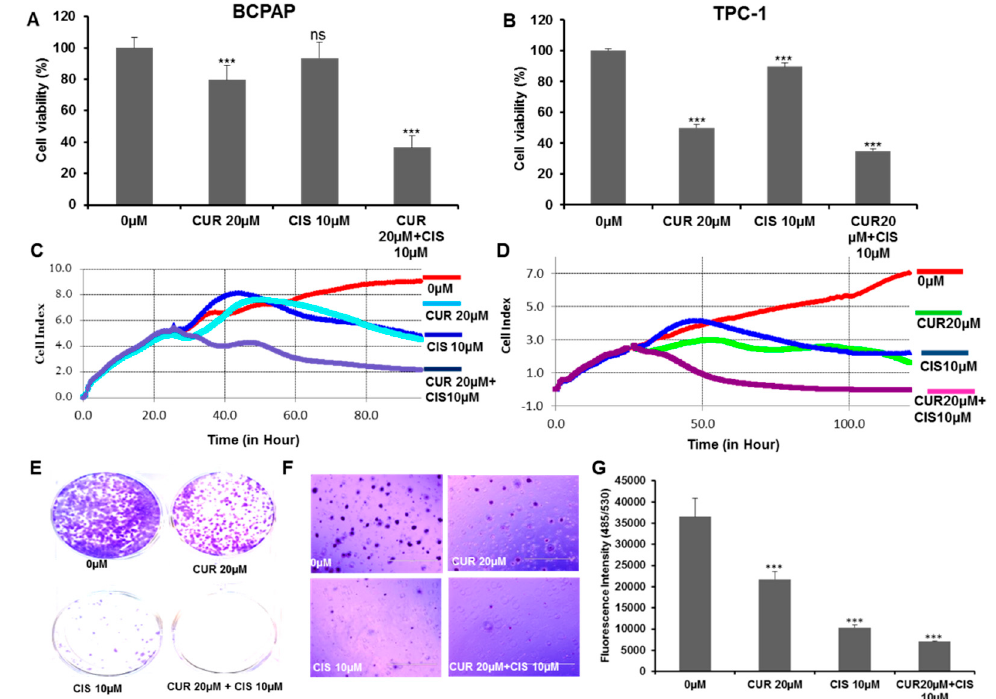
Figure 4. Cotreatment of curcumin with cisplatin augmented the inhibition of cell growth and proliferation and suppressed the motility of PTC cells. Curcumin synergistically enhanced the growth inhibitory potential of cisplatin in BCPAP ( A ) and TPC-1 ( B ) cells. BCPAP and TPC-1 cells were treated with 0 µ M or 20 µ M of curcumin and 10 µ M cisplatin alone and in combination for 24 h. A cell proliferation assay was performed using a CCK8 kit, as described in the materials and methods section. Values were expressed as the mean +/ − the SD of at least six replicates, with a p -value od *** p < 0.001. ( C , D ) Real-time cell proliferation (cell index) analysis of BCPAP and TPC-1 cells treated with curcumin and cisplatin, respectively. BCPAP and TPC-1 cells were cultured on electrodes and treated with 20 µ M curcumin and 10 µ M cisplatin alone and in combination followed by the monitoring of real-time cell growth, as mentioned in the material and methods section. ( E – G ) Curcumin synergistically inhibited the colony formation potential of cisplatin. BCPAP cells were cultured in a six-well plate with and without agar and treated with 0 µ M or 20 µ M curcumin and 10 µ M of cisplatin alone and in combination for one to two weeks. Colonies were stained with crystal violet, and fluorescence intensity using CyQuant dye was measured at 485 / 530 nm. Data are presented as the mean +/ − the SD, *** p < 0.001. Curcumin (CUR), cisplatin (CIS).